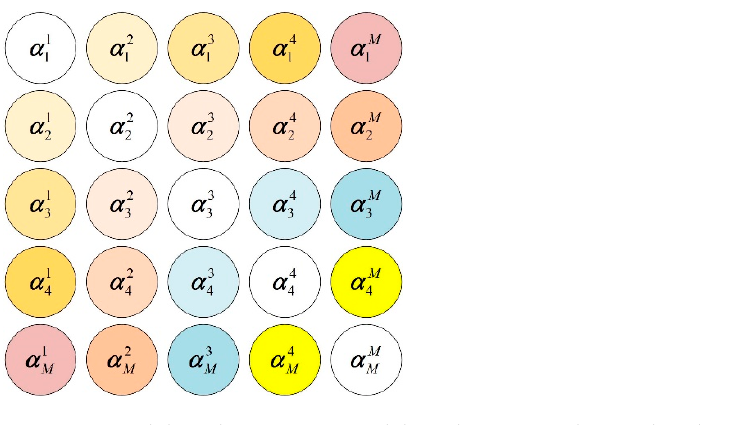
Figure 5. Graph based constraints model. Each vertex in the graph indicates a set of dual variables, and the sum of each vertex with the same color is equal. As shown in Figure 5, there are M × M vertices in the graph, where each vertex indicates a set (cid:12) (cid:110) (cid:111) (cid:12) = ≤ i ≤ N , y = 1, m (cid:48) = 1 α m (cid:48) of dual variables, i.e., a 1 . The constraints in Equation (23) can i (cid:12) 1 i 1 be described visually via the graph-based constraints model, where the value of dual variables in each vertex should be between 0 and C , and the sum of the values for dual variables contained in the vertices ( i , j ) is equal to that in vertex ( i , j ), i.e., the vertex with the same color in Figure 5 should have the same sum. Since updating the variables contained in the vertices of the same color does not affect the feasibility of other variables, it is taken into consideration to select variables from the vertices of the same color as the working